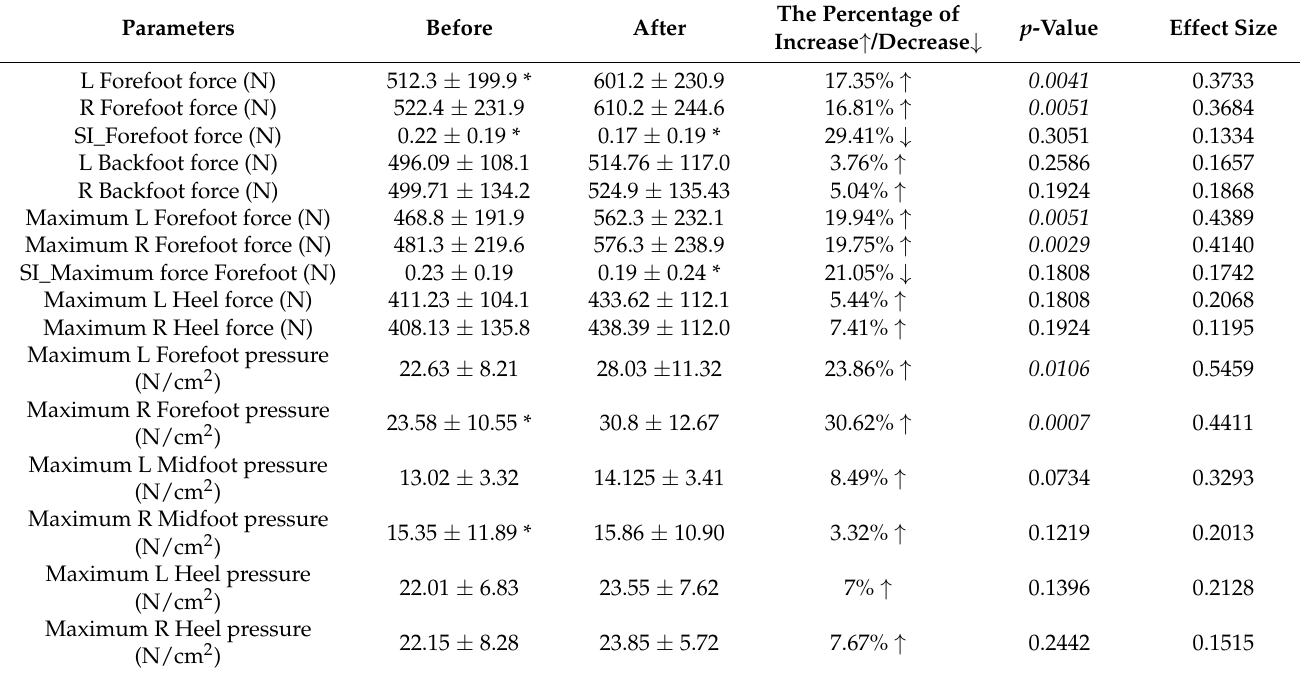
L—left lower limb, R—right lower limb, ↑ / ↓ —the percentage of increase/decrease in parameter values in a given group after rehabilitation; significant p -values are indicated in italics; * indicates parameters with distributions different than normal. Table 5. Results (mean ± SD) of Wilcoxon test/ t -test ( p < 0.05) and effect size for comparison before and after rehabilitation within control group for force and pressure